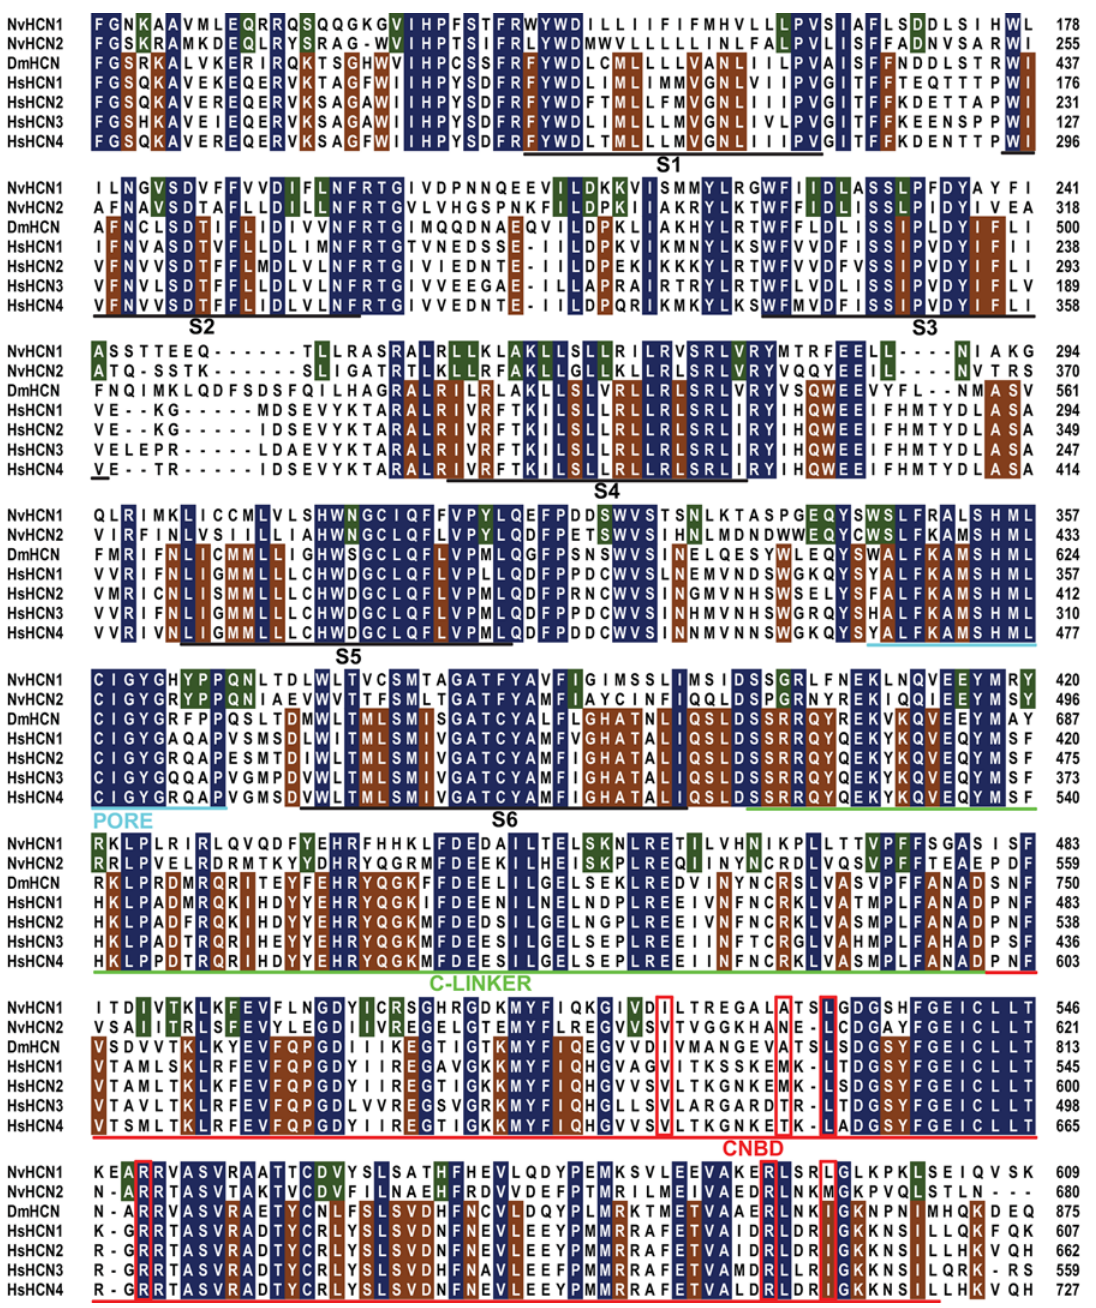
Fig 1. Multiple amino acid sequence alignment comparing sea anemone, human and Drosophila HCN channels. The alignment compares two putative HCN channels from the sea anemone Nematostella vectensis (NvHCN1 and NvHCN2) to HCN channels from Drosophila (DmHCN) and human (HsHCN1-4); residue positions are given at the right margin. Positions identical in all sequences are shaded in blue, and additional residues identical in Nematostella or the bilaterian sequences are shaded in green or brown, respectively. Approximate positions of 6 transmembrane domains (S1-S6) and the selectivity filter (PORE) are underlined and labeled in black or cyan, respectively. The C-linker is underlined in light green and the CNBD is underlined in red. Residues that contact cAMP in an HCN2 structure are boxed with a red outline. Accession numbers and full sequences are provided in S1